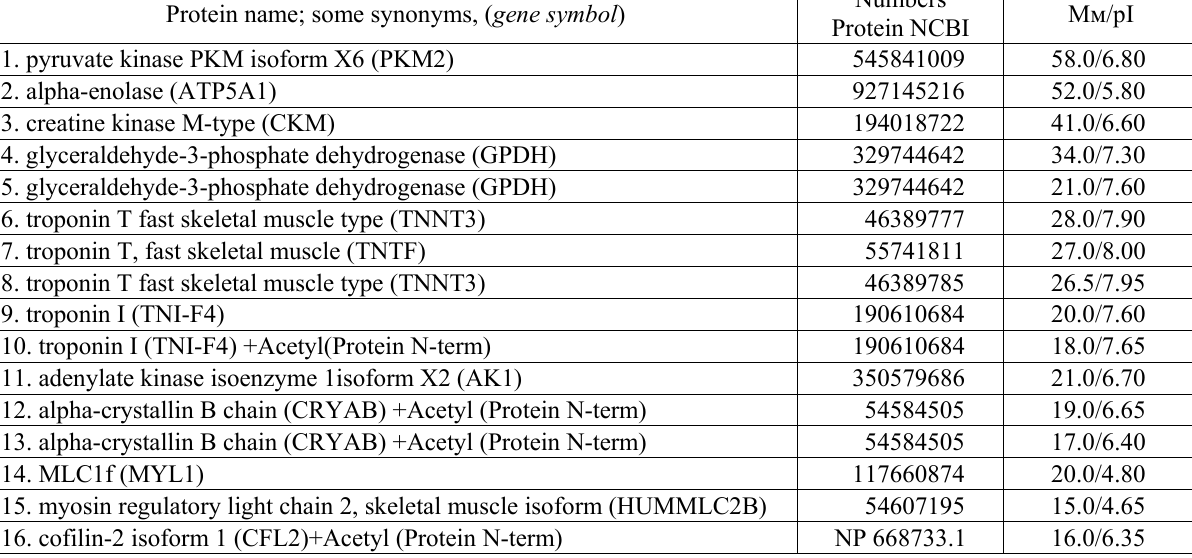
Table 1. Results of mass spectrometric identification of pork M. Longissimus dorsi protein fractions on the fifth day of